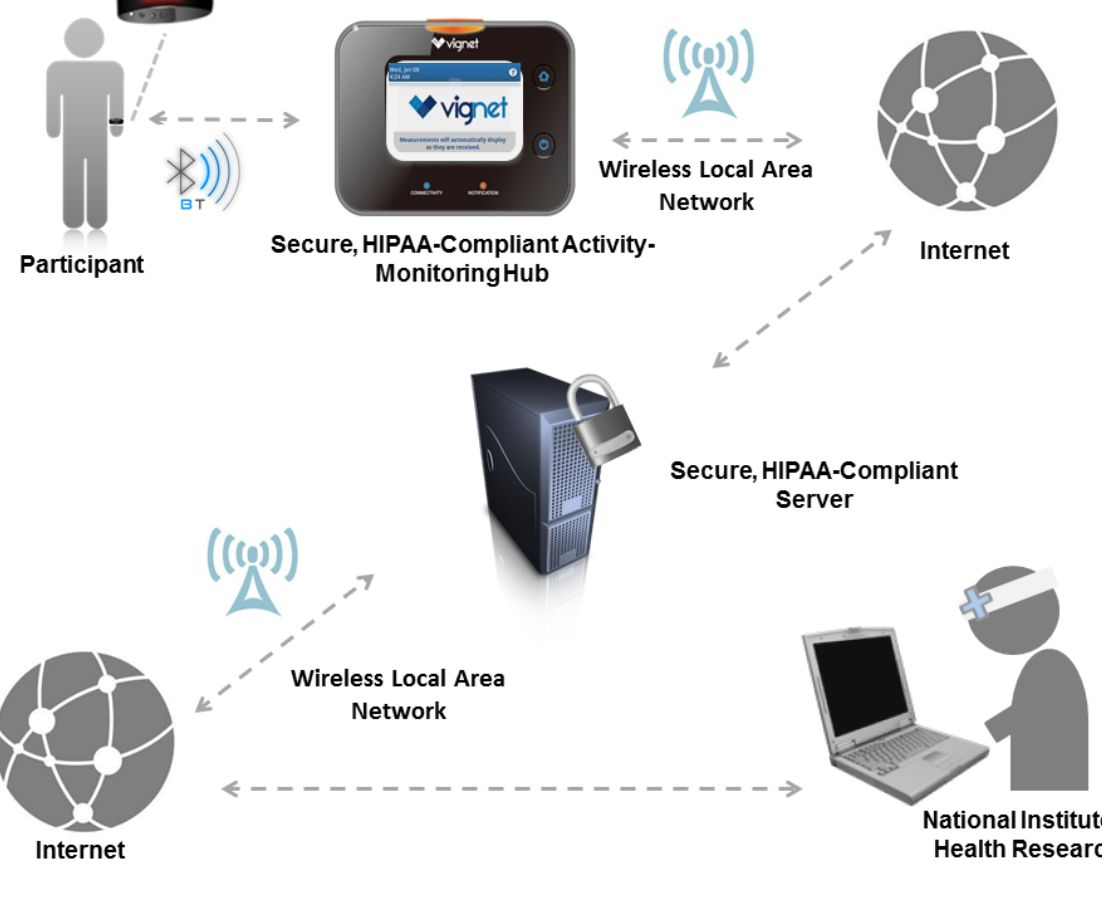
Figure 1. Secure data collection process; Cardiovascular Health and Needs Assessment Qualitative Study, 2014. HIPAA: Heath Insurance Portability and Accountability